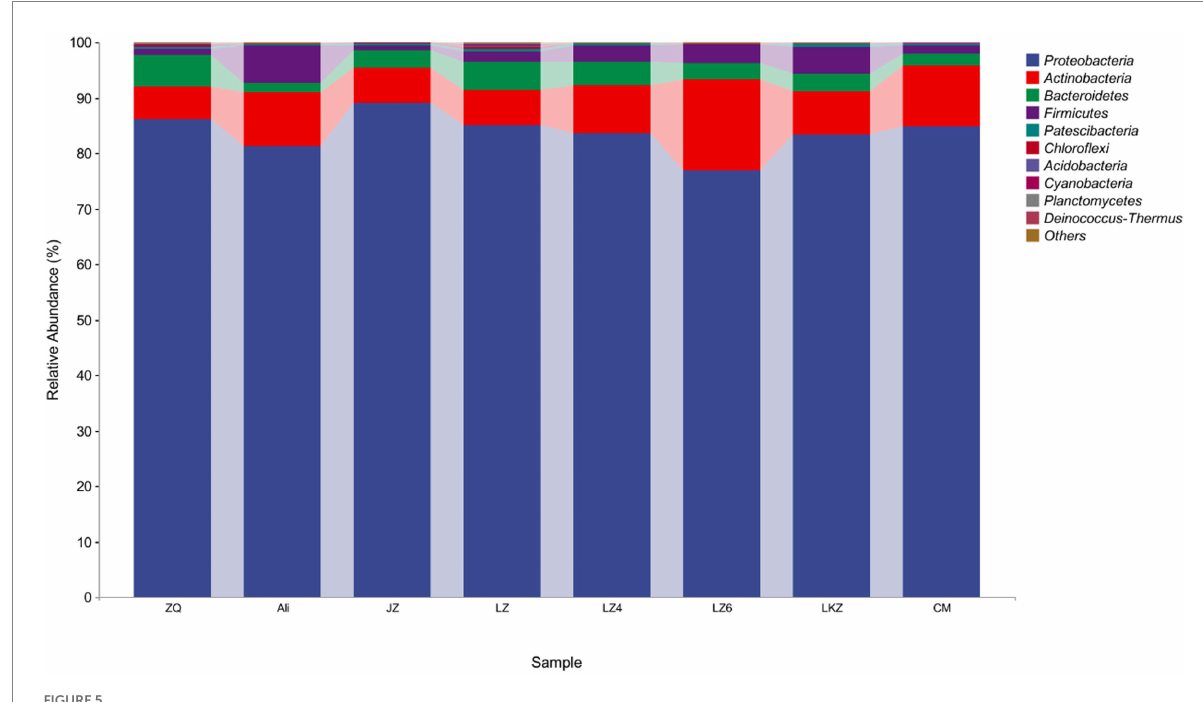
FIGURE 5 The phylum level relative abundances of the endophytes from the seeds of highland barley varieties. CM, Cuomei; JZ, Jiangzi; LZ, Lazi; LZ4, Longzi4ling; LZ6, Longzi6ling; LKZ, Langkazi; and ZQ, Zangqing 2000.